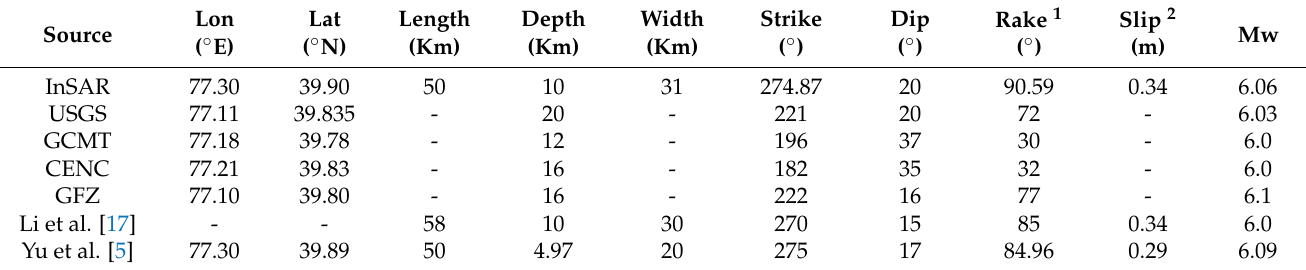
Figure 4. Slip distribution of the Jiashi earthquake inverted from InSAR data. The yellow star represents the Retrieved Epicenter Position. The slip direction of the coseismic deformation field is indicated by black arrows. The size of the arrow represents the amount of sliding. Table 3. Focal mechanism solutions of the Jiashi earthquake